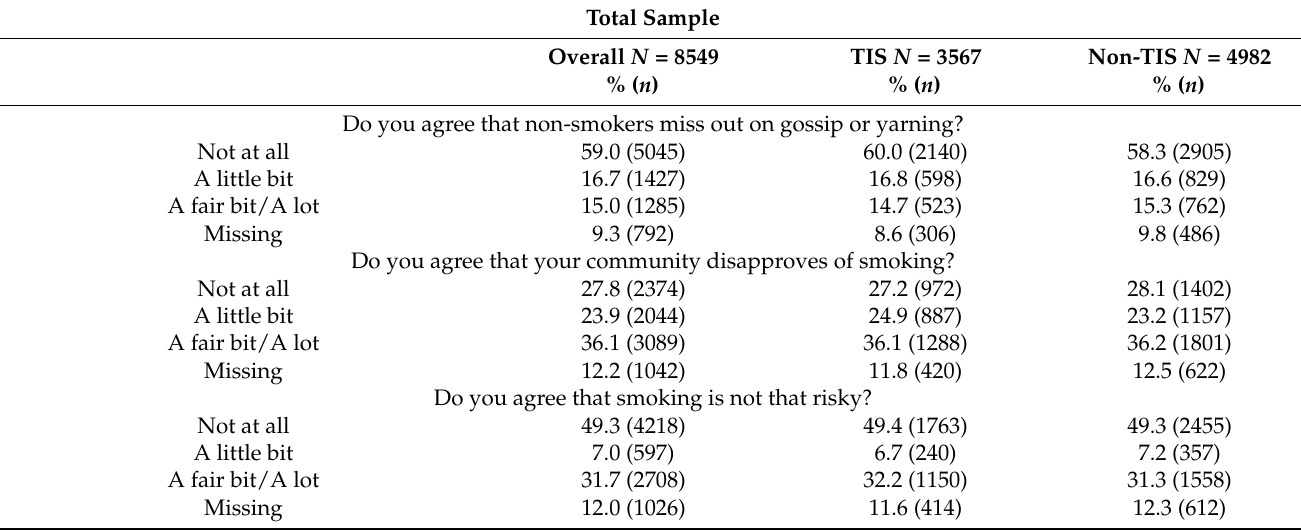
Table 3. Smoking-related attitudes in the total sample, current smokers only, and past smokers only, overall and by